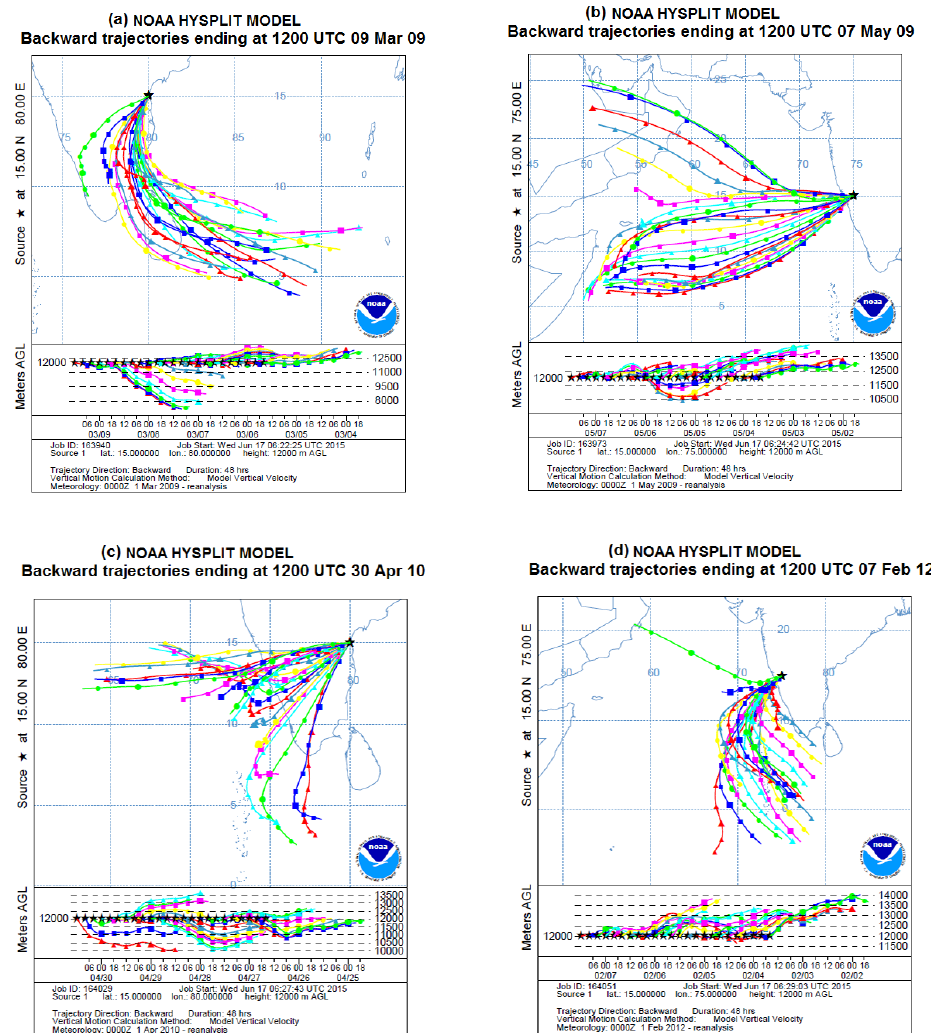
Figure 9. (a–b) 48h back trajectory ending at 12:00UT on 9 March and 7 May 2009 using National Oceanic Atmospheric Administration (NOAA) HYSPLIT model. (c–d) Same as (a) – (b) but on 30 March 2010 and 7 February